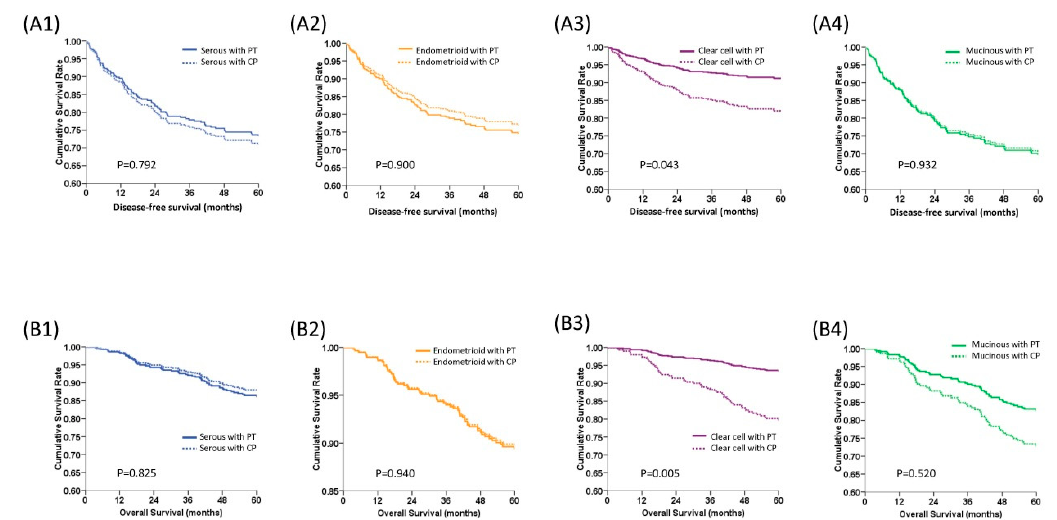
Figure 2. Survival curves of 437 early stage epithelial ovarian carcinoma women stratified by chemotherapeutic regimens and histologic type with multivariate Cox regression models after adjusting for FIGO stage, tumor grade, and age at diagnosis. ( A ) Estimated 5-year disease-free survival (DFS) curves. A1 : Serous type, A2 : Endometrioid type, A3 : Clear cell type, A4 : Mucinous type. Patients with clear cell histology treated with platinum and paclitaxel (PT) regimens had significantly longer 5-year DFS than those treated with platinum and cyclophosphamide (CP) regimens (91.2% vs. 82.0%, aHR = 0.45, 95% CI = 0.21–0.93, p = 0.043, log-rank test). The 5-year DFS of the other histologic types did not differ with PT or CP regimens. ( B ) Estimated 5-year overall survival (OS) curves. B1 : Serous type, B2 : Endometrioid type, B3 : Clear cell type, B4 : Mucinous. The 5-year OS rate of patients with clear cell histology (93.5% vs. 79.0%, aHR = 0.30, 95% CI = 0.13–0.70, p = 0.005) treated with PT regimens was also higher than those treated with CP regimens. There was no difference in 5-year OS, regardless of treatment with PT or CP regimens, in patients with the serous (86.2% vs. 87.8%, p = 0.825), endometrioid (89.4% vs. 89.7%, p = 0.739), and mucinous (aHR = 0.63, 95% CI = 0.16–2.38, p = 0.520) types (all by log-rank test).